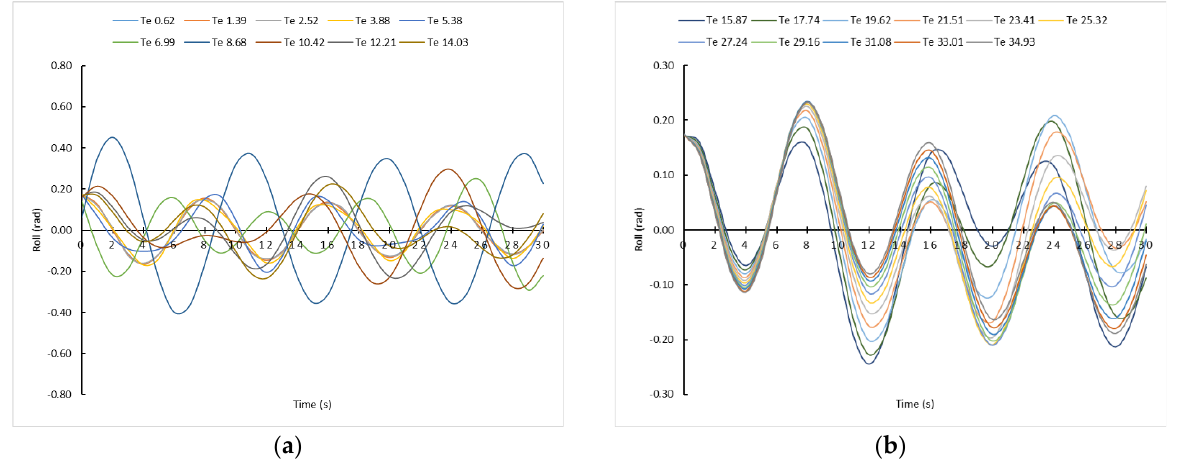
Figure 6. Rolling motion sailing at 8.0 knots and induced by waves with resistance with an α angle of 45°. Td = 8 s. θ MAX = 10°. ( a ) Te from Te 0.62 s to 14.03 s. ( b ) Te from Te 15.87 s to 34.93 s.